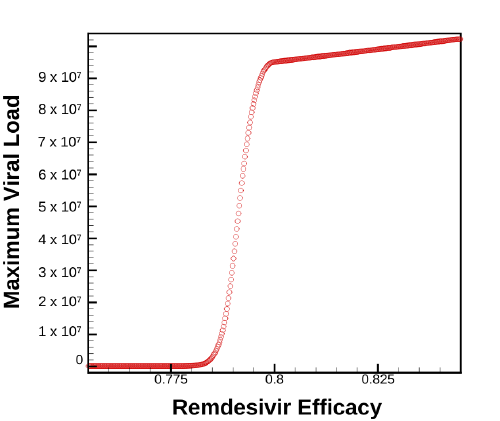
Figure 6. Maximum viral load as a function of time for varying levels of Remdesivir treatment combined with 75% efficacious host-cell entry inhibitor